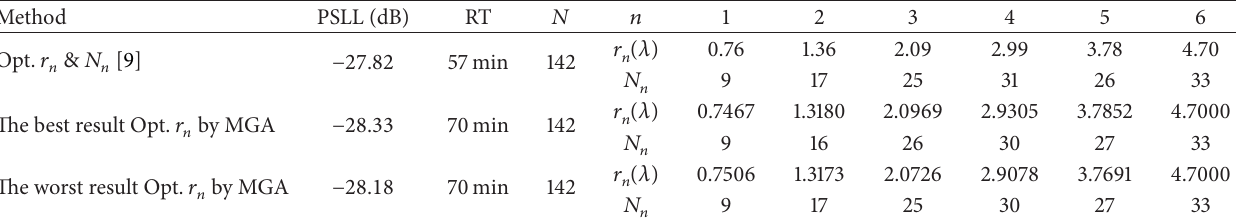
Table 2: Peak sidelobe level (PSLL), modified real genetic algorithm (MGA), number of elements ( 𝑁 ), run time (RT), ring radii ( 𝑟 𝑛 ), and number of elements in the rings ( 𝑁 𝑛